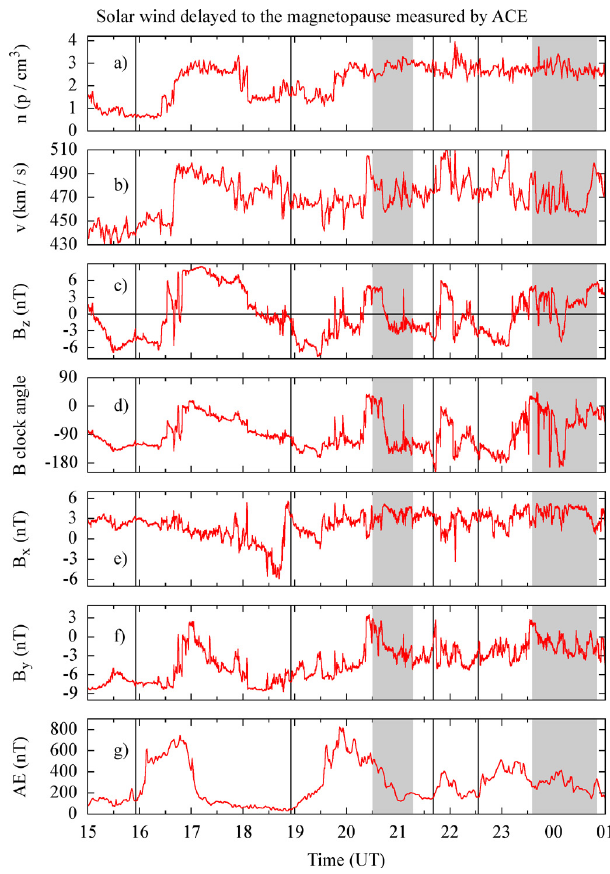
Fig. 4. (a) density, (b) velocity, (c) B z , (d) clock angle, (e) B x , (f) B y of the delayed solar wind measured by ACE on 18 February 2004 at x GSE = 221 R E and (g) the provisional AE index from Ky- oto AE index service. Vertical black lines mark the start of the AE intensifications, vertical grey bars mark the plasmoids formed in the